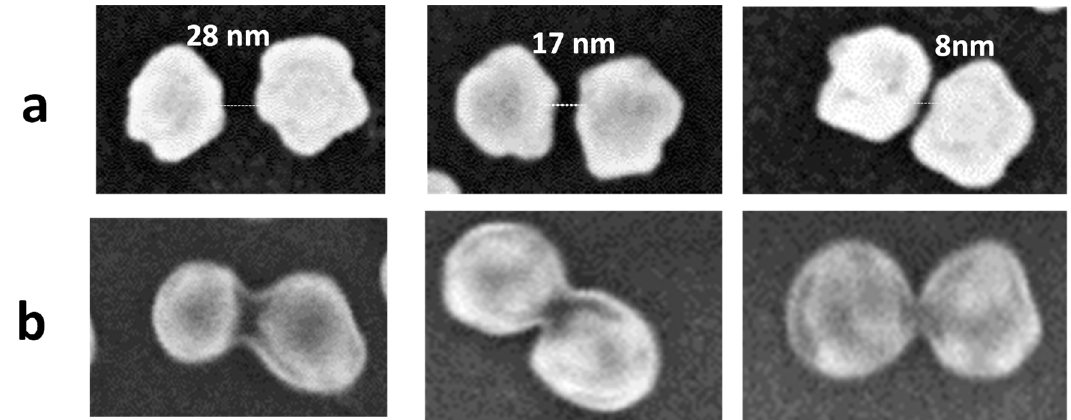
Figure 5. ( a ) AuNP dimers separated by gaps ranging from 8 to 30 nm. ( b ) AuNP dimer connected by an oligo (ADP) layer after irradiation of the plasmonic electrode in 4-Aminodiphenyl diazonium solution for 15 min.